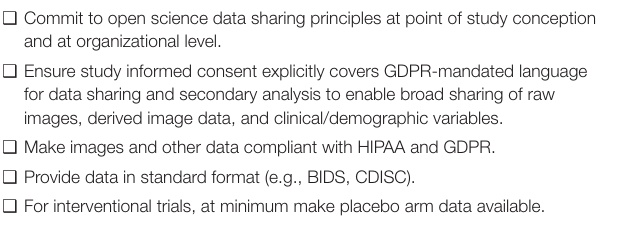
TABLE 4 | Broad sharing of imaging data from interventional trials and observational studies. q Commit to open science data sharing principles at point of study conception and at organizational level. q Ensure study informed consent explicitly covers GDPR-mandated language for data sharing and secondary analysis to enable broad sharing of raw images, derived image data, and clinical/demographic